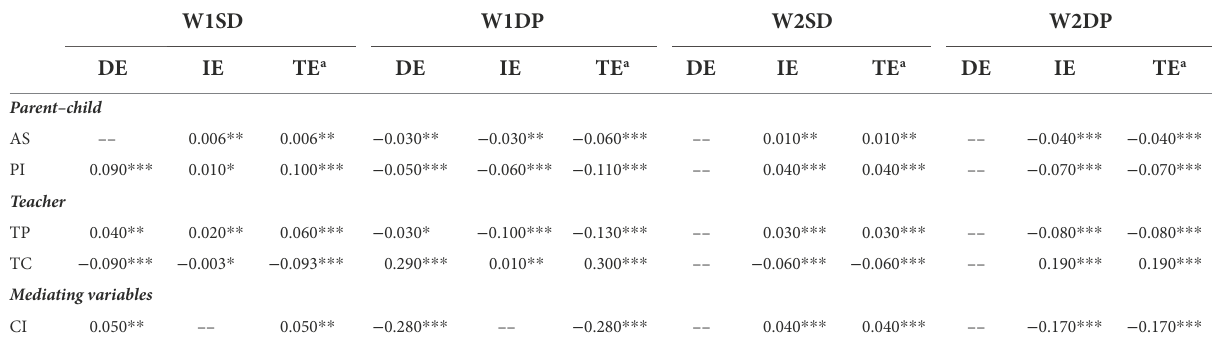
TABLE 3 Descriptive statistics for the direct effect, indirect effect and total effect of the critical Parent–child/teacher factors, and mediating variable on adolescents sleep duration and depression.